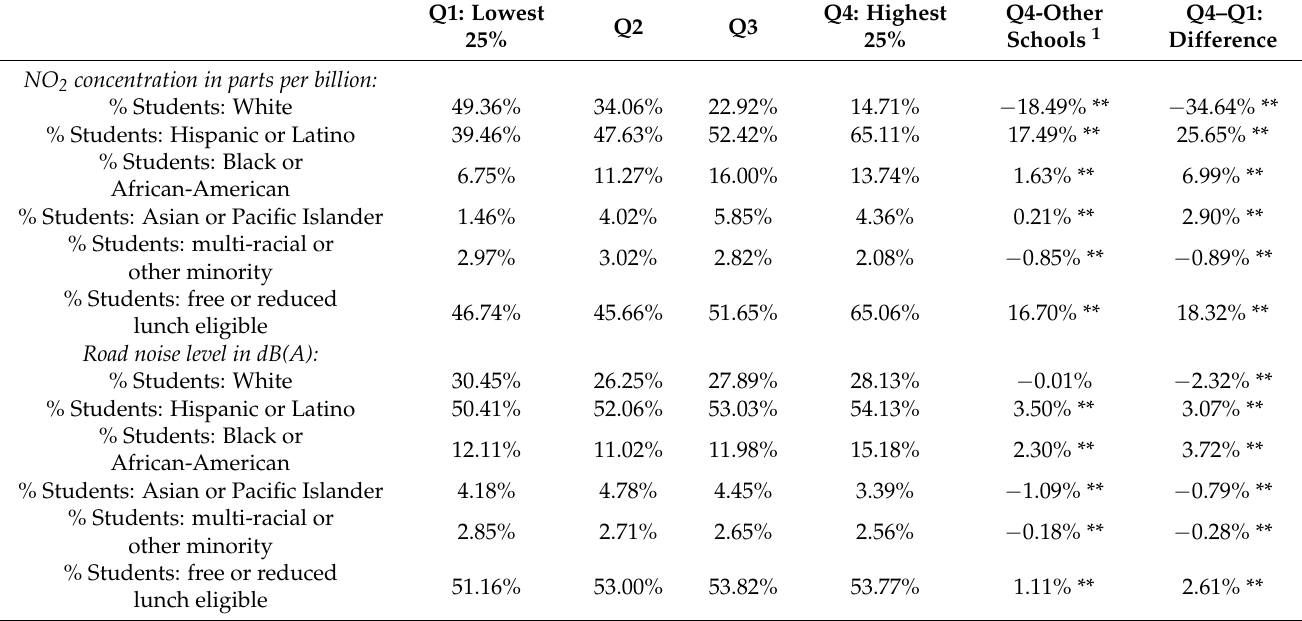
Table 2. Distribution of Texas public school students across traffic-related air and noise pollution exposure quartiles.